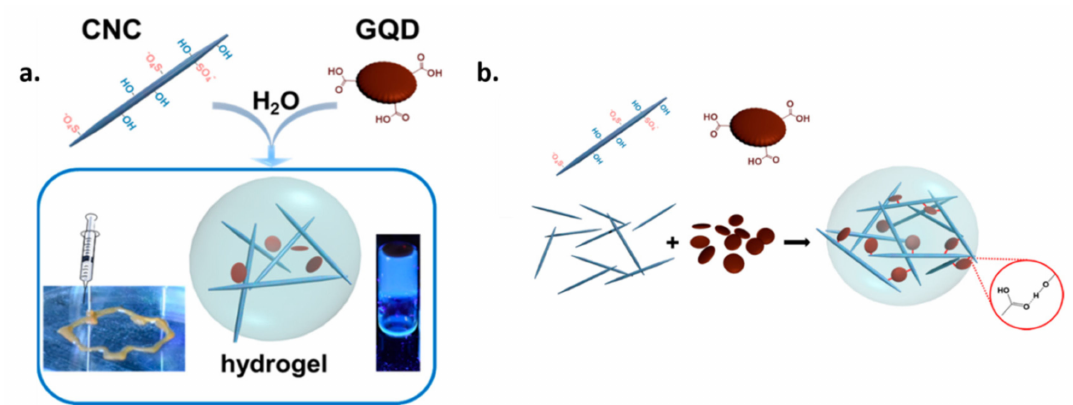
Figure 8. Schematic representation of the CNCs and GQDs hydrogels building blocks and illustration of the shear thinning behavior and photoluminescence properties ( a ) Hydrogen bonds formation between GQDs and CNCs upon mixing ( b ) [112]. Reproduced with copyright